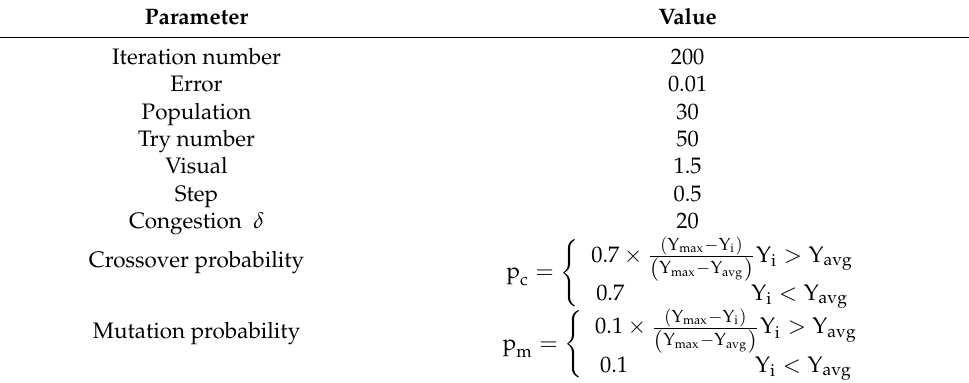
Table 7. Parameters of adaptive hybrid artificial fish swarm genetic algorithm.